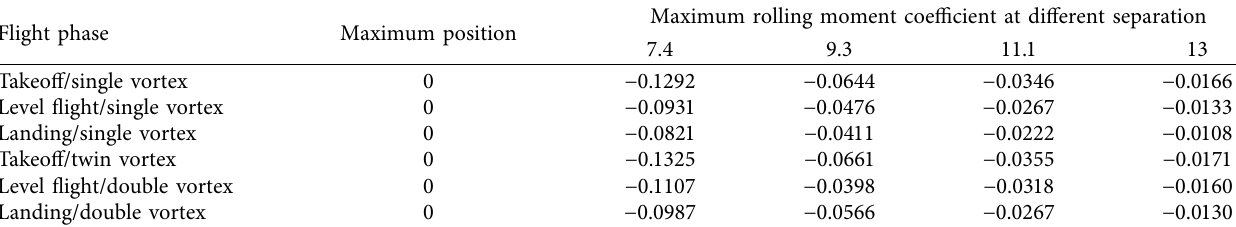
Figure 12: Variation of rolling moment coefficient with distance from vortex core when encountering double vortex. (a) Takeoff phase. (b) Level flight phase. (c) Landing phase. Table 9: Maximum rolling moment coefficient.